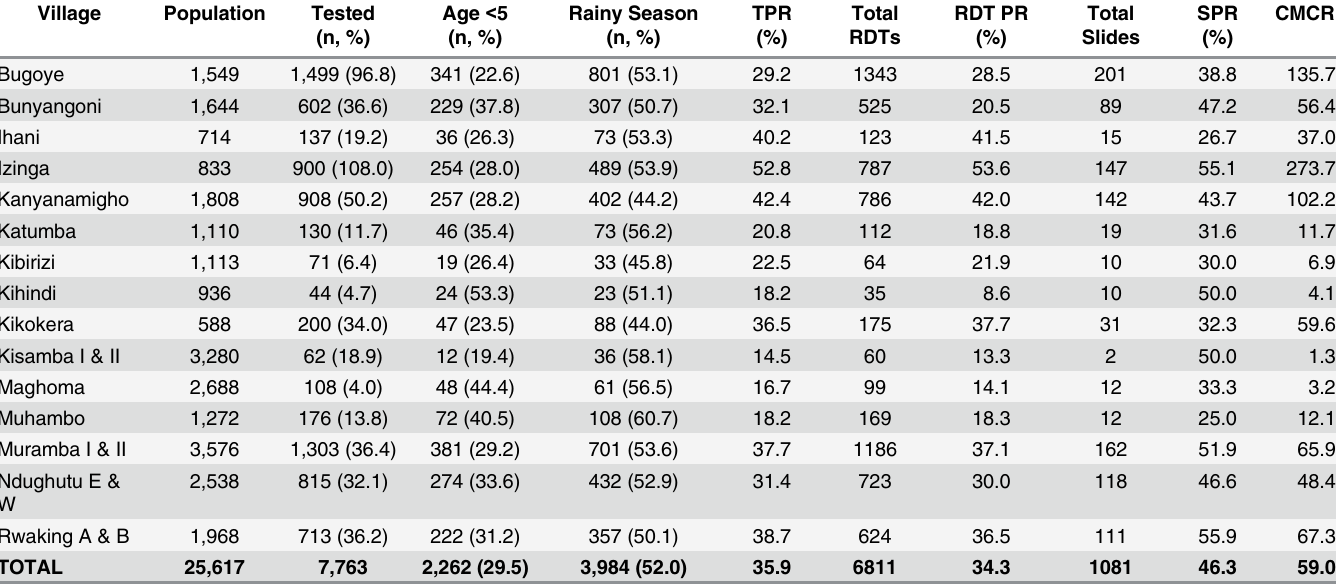
Table 1. Summary of diagnostic testing results by village over the 24-month study